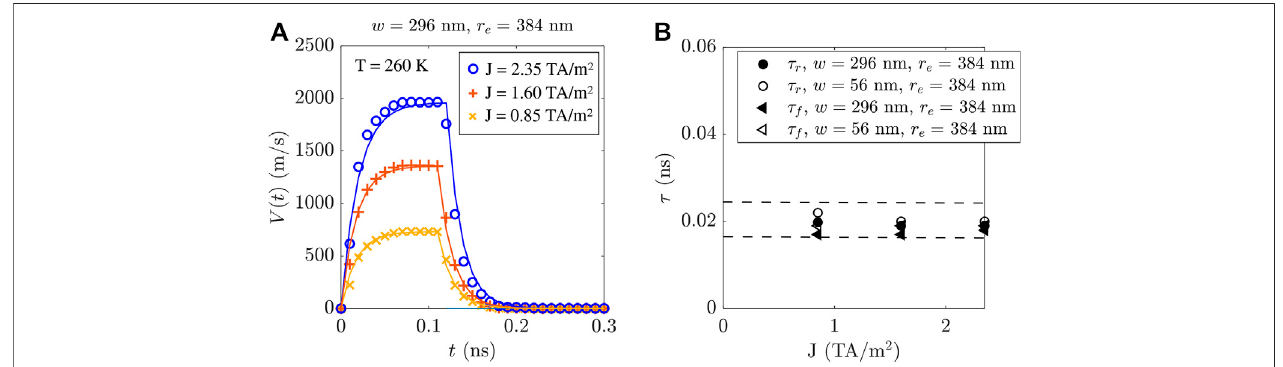
FIGURE4| InstantaneousDWvelocities V ( t )forthreevaluesofJandforacurvedstripof r e (cid:2) 384 nmand w (cid:2) 296 nmat T (cid:2) T A (A) .Symbolsarethe μ mdata,from which τ (rise and fall times) are extracted for the narrowest and widest strips (B) . Dashed lines in (B) are the upper and lower bounds of a 95 % con fi dence interval.